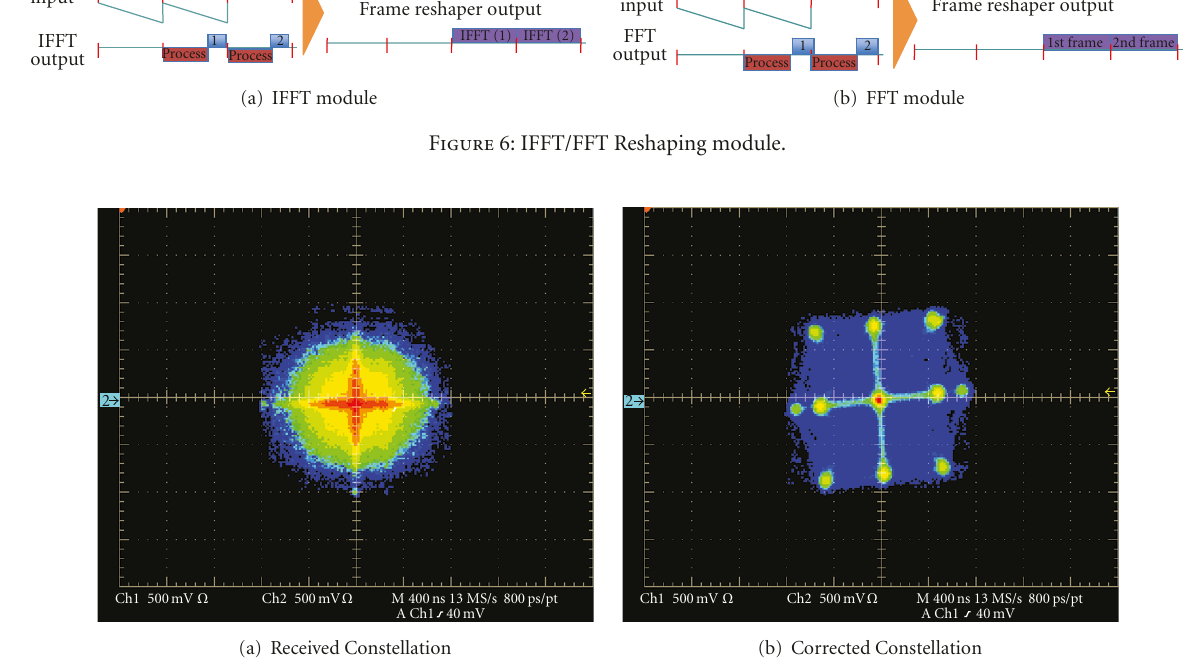
Figure 7: Constellations for QPSK at Antenna 1 at SNR =